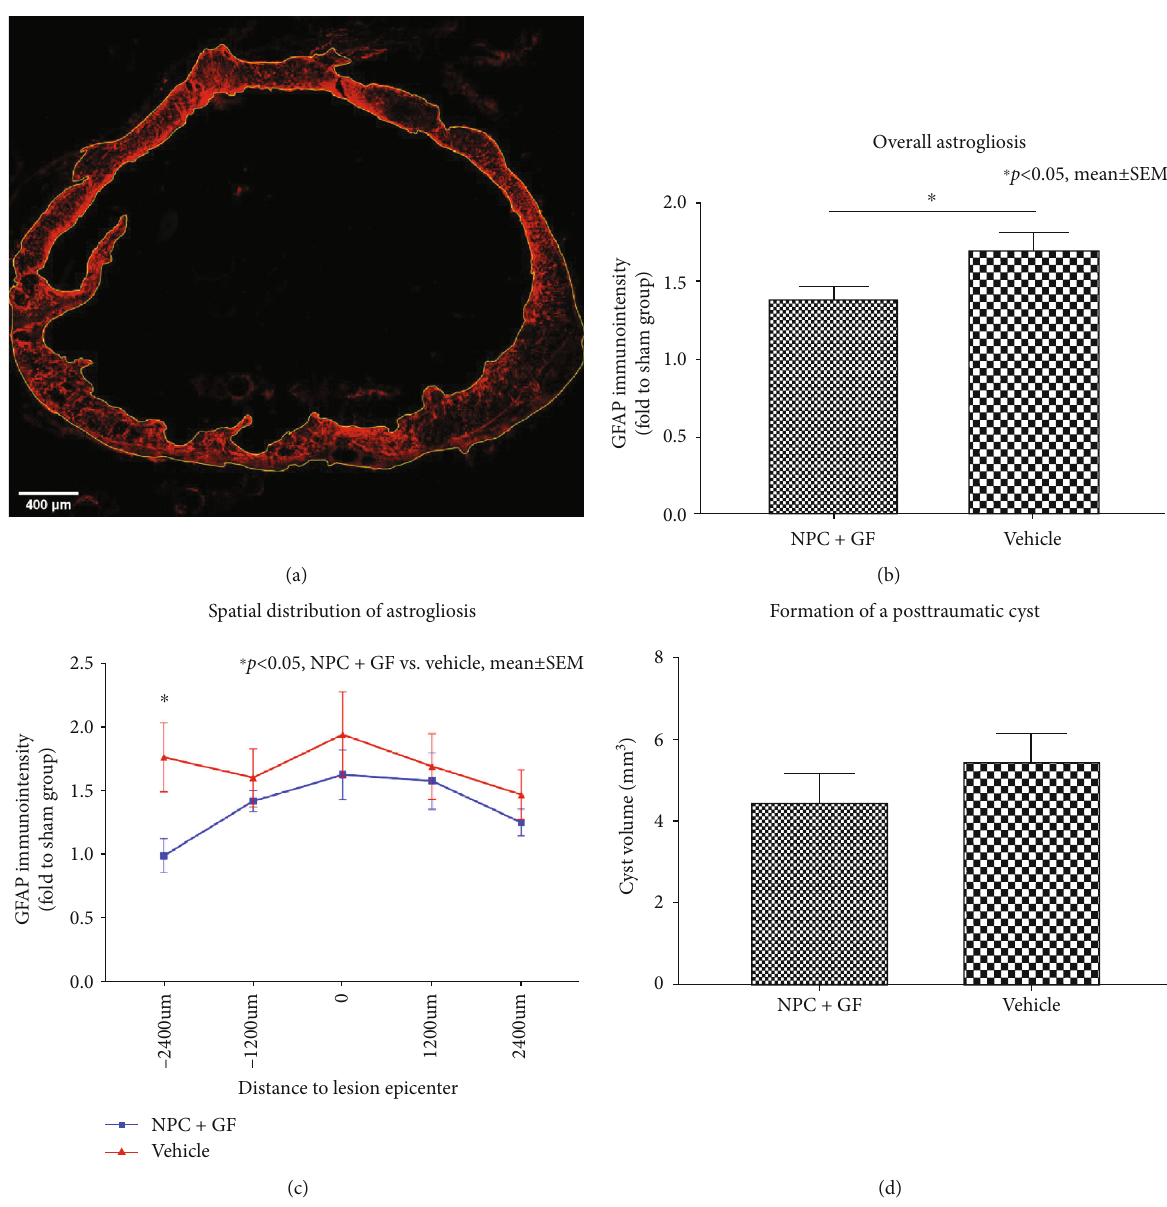
Figure 7: In vivo astrogliosis and cyst formation 8 weeks after cervical SCI. (a) Spinal cord cross-section stained for GFAP (red) with ROIs (yellow) drawn around the entire spinal cord as well as the intramedullary, posttraumatic cyst (10x magni fi cation). (b) Overall GFAP- immunointensity and (c) spatial distribution of GFAP-immunointensity expressed in proportion to (fold to) the sham group as a marker for reactive astrogliosis in the injured spinal cord. (d) Volume of the posttraumatic intramedullary